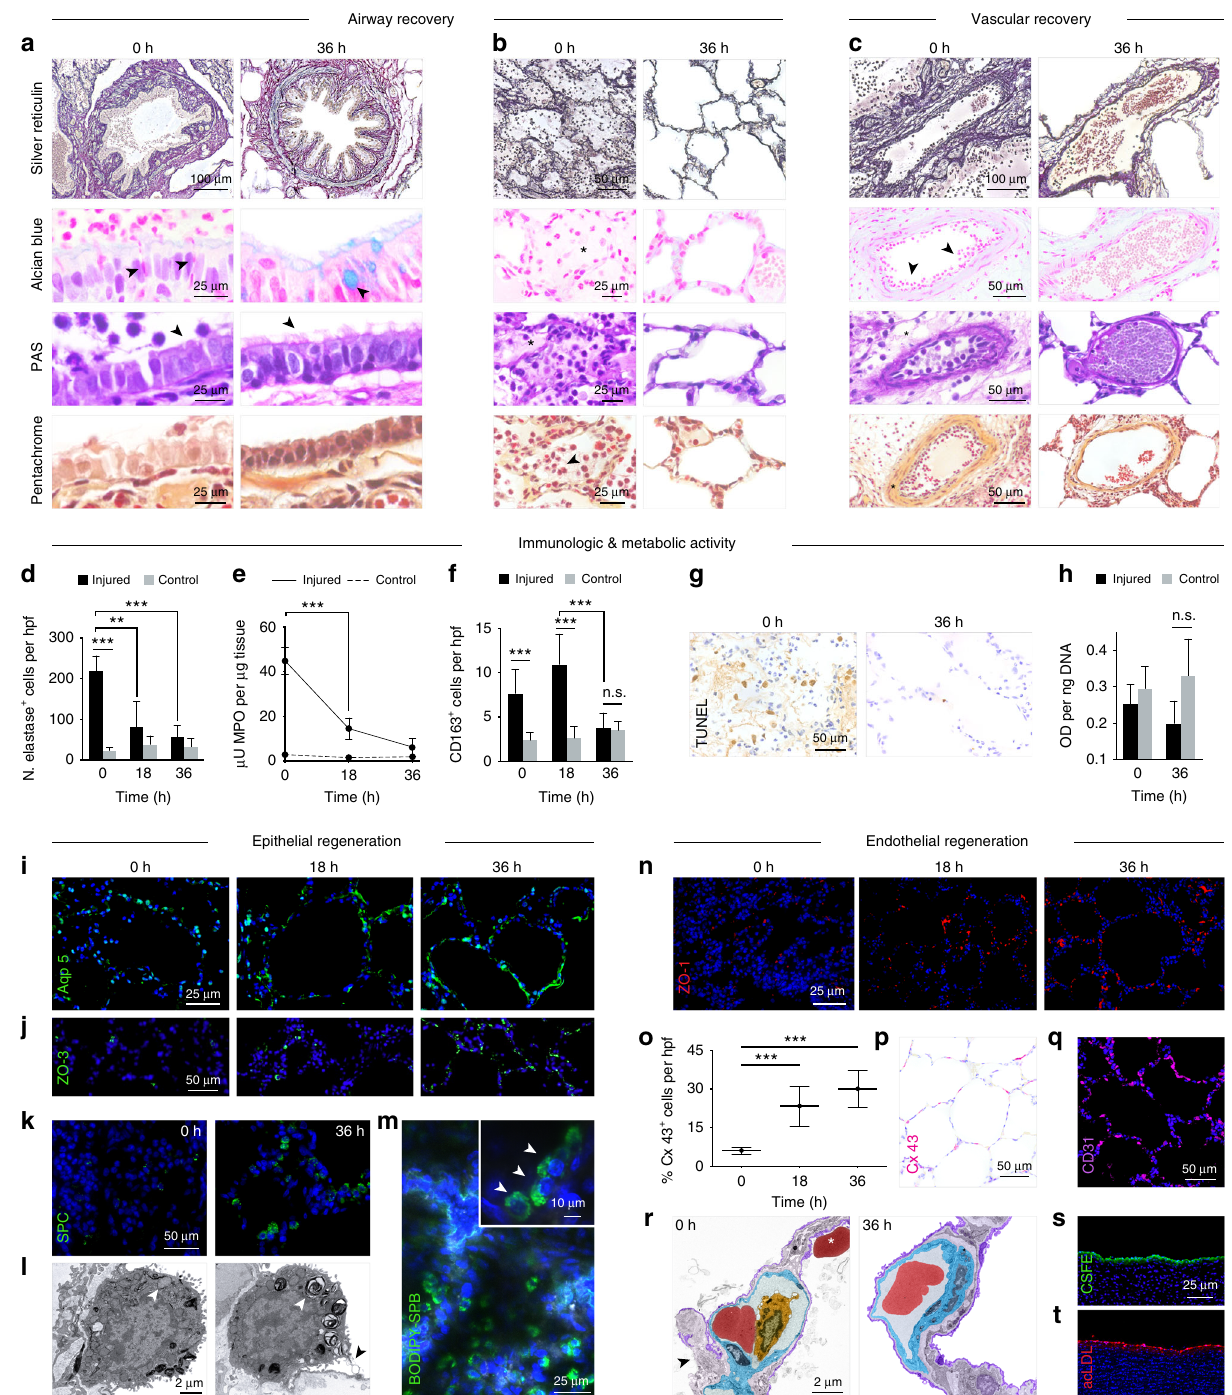
and the presence of in fl ammatory cells, extravascular erythro- cytes, and extracellular debris con fi rmed lung injury and a compromised blood – gas barrier (Fig. 6r; Supplementary Fig. 7b). After 36 h of cross-circulation, the pulmonary microvasculature of injured lungs appeared intact by immunostaining for CD31 (Fig. 6q), and the transmission electron micrographs (Fig. 6r; Supplementary Fig. 7b) resembled those of control lungs (Supplementary Fig. 7c), with clear restoration of the alveolar epithelial lining and intraseptal capillary geometry and architec- ture (Supplementary Fig. 7b). Viability of the pulmonary